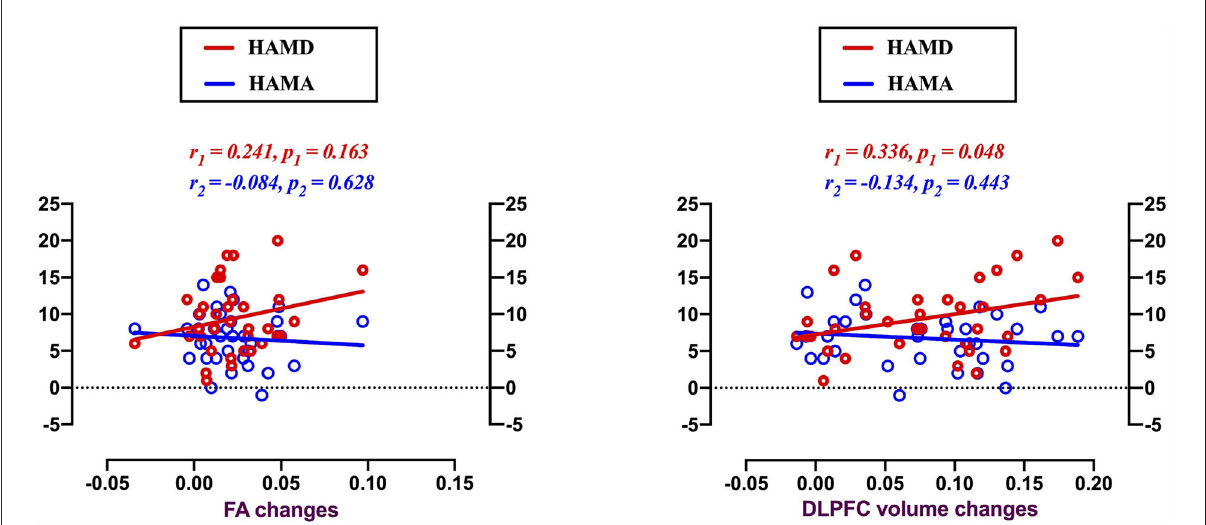
FIGURE5 Voxel-based morphology comparison between MMD patients and HCs, and correlations between the reduction volumes and depression symptoms. Scatter plots indicating gray matter volume alterations in the DLPFC were found positively correlated with the HAMD score changes in MMD patients after 8 weeks SG-treatment (r = 0.336, p = 0.048). There were no significantly correlations between clinical symptom changes and FA value